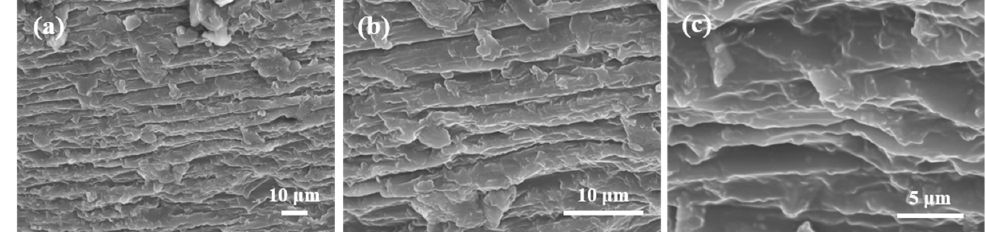
Figure 4. SEM images of unpolished SunFO with MoS 2 coating on the SS observed by SEM: ( a ) 1000 × ; ( b ) 3000 × ; ( c ) 5000 × .